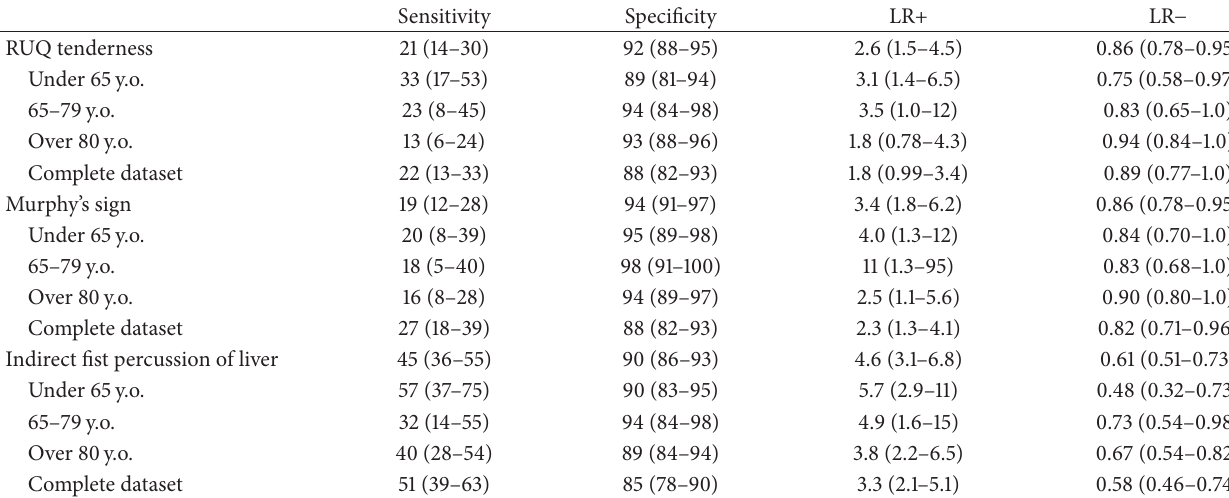
Table 3: Diagnostic accuracy for hepatobiliary diseases.